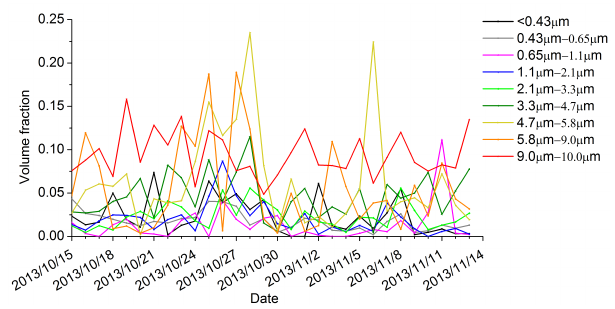
Figure 5. Time series of the volume fraction of EC for different size segments during the observation